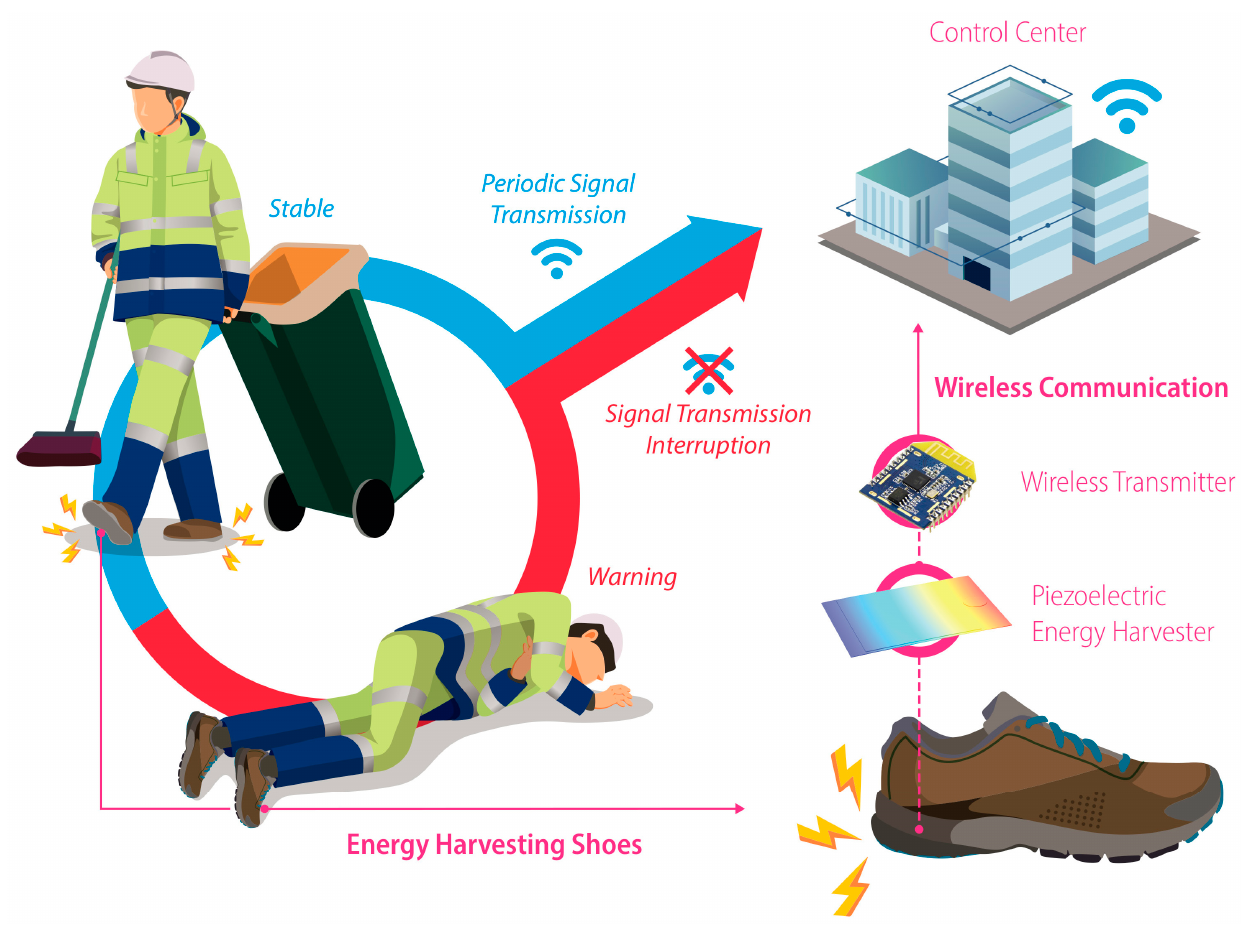
Figure 1. Wireless communication system between worker and control center.